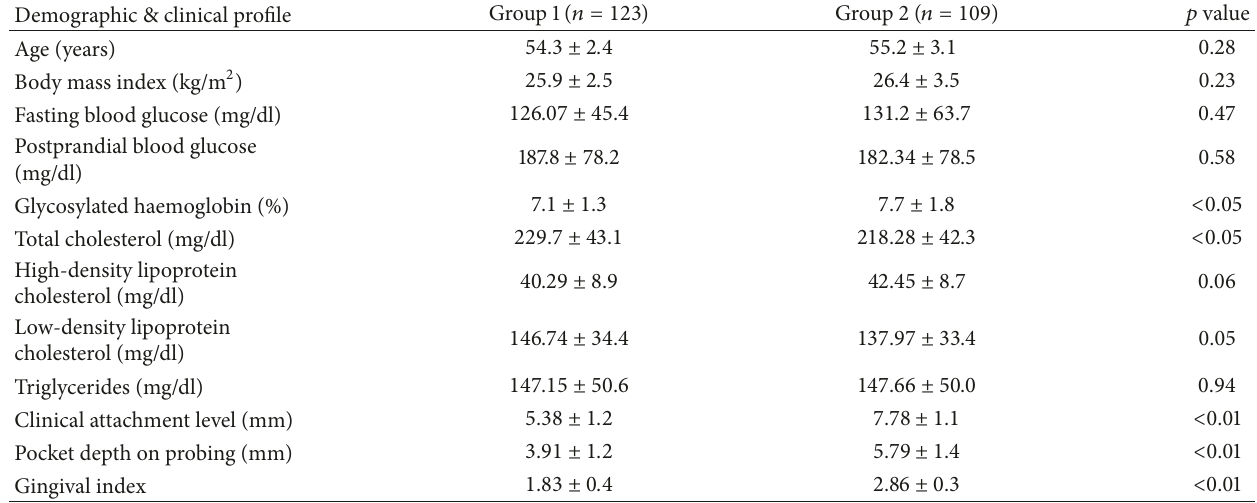
Table 1: Descriptive statistics between groups.